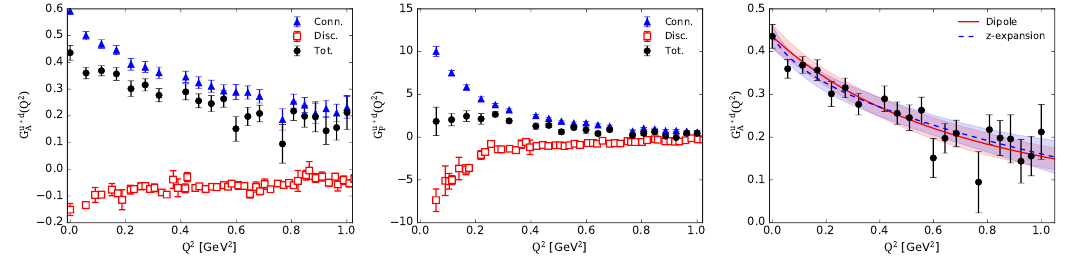
( Q 2 ) (left) and G u + d ( Q 2 ) (mid- Figure 7: Renormalized results for the isoscalar G u + d A P dle) as a function of Q 2 . We show separately the connected (blue triangles) and the disconnected (open red squares) contributions as well as the sum (black circles). Open symbols are used for the form factors versus Q 2 when showing only discon- nected contributions. Right: With the solid red line we show the dipole fit and the ( Q 2 ) . Figure taken from Ref. [ 26 ] . dashed blue of the z-expansion fit to G u + d A